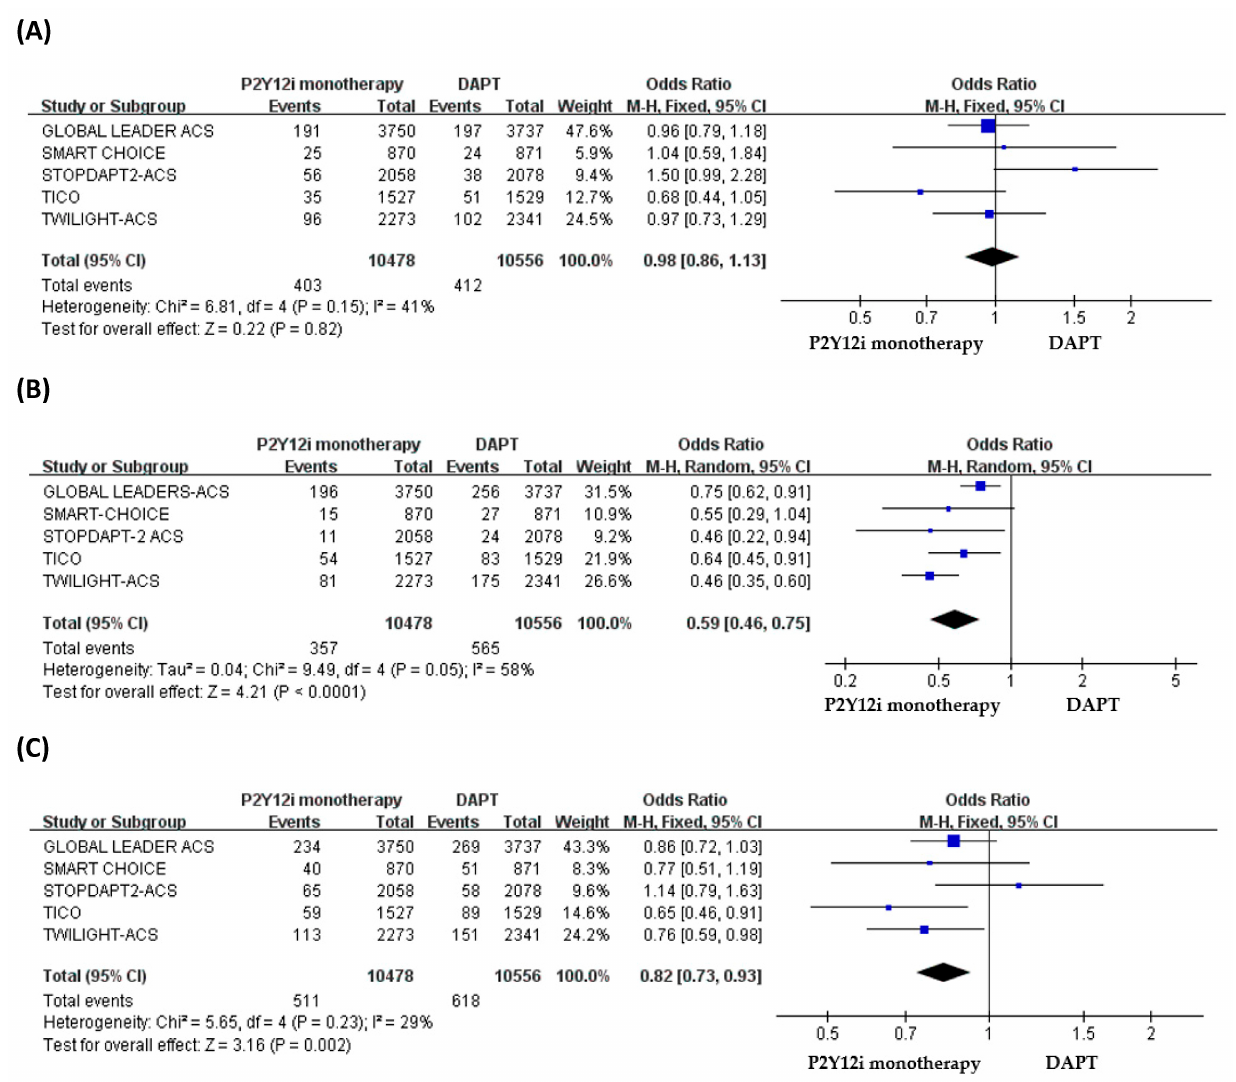
Figure 2. The efficacy and safety of P2Y12 inhibitor monotherapy in patients with ACS after PCI as compared with 12-month DAPT. ( A ) MACCE, ( B ) bleeding events, ( C ) NACE.